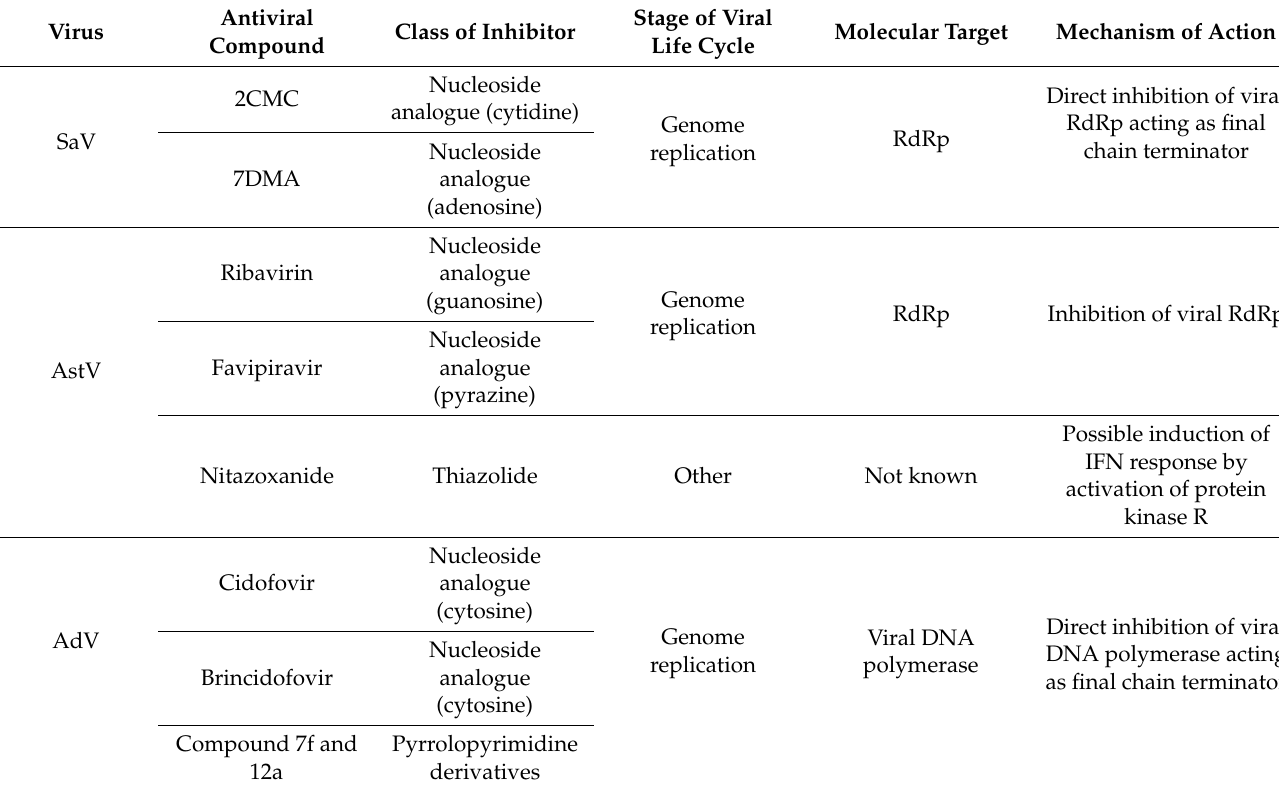
Table 3. Antiviral compounds for sapovirus, astrovirus, and enteric adenovirus infections within this review.